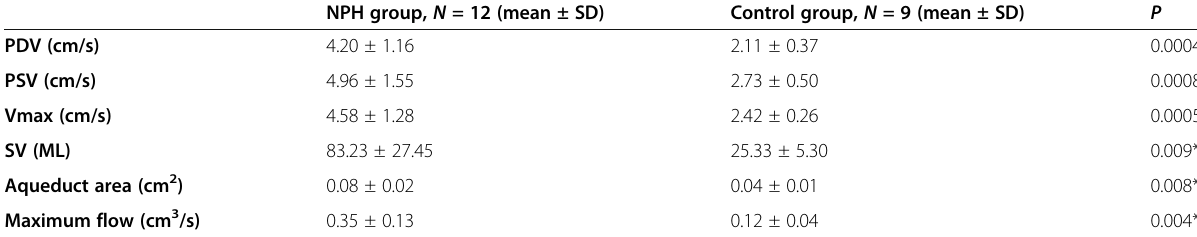
Table 2 Analysis of difference between normal pressure hydrocephalus (NPH) versus control group ( t test)